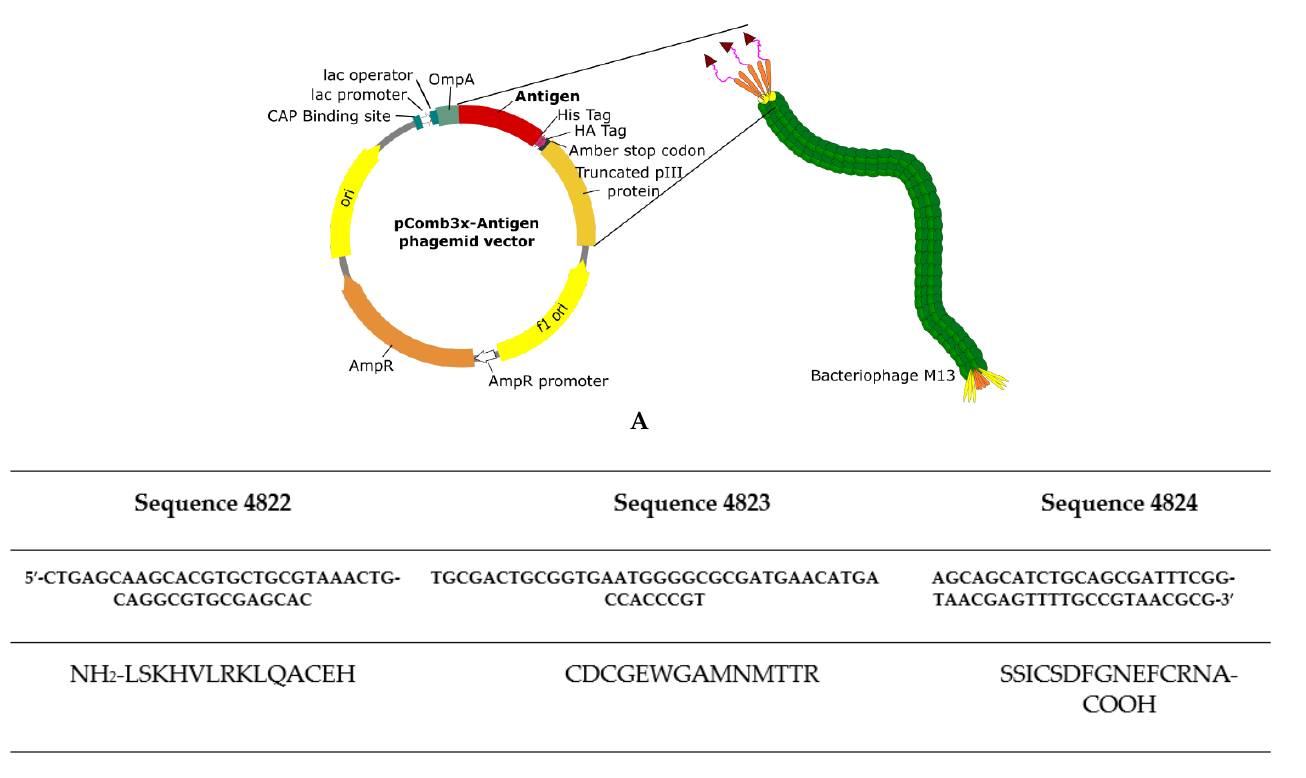
Figure 1. Schematic representation of the phage-based vaccine design. ( A ). A pComb3x phagemid vector was used to fuse antigens to a truncated pIII protein of bacteriophage M13. It contains a His-tag at the carboxy-terminal to the antigen fragment for IMAC purification. A hemagglutinin (HA) tag was also inserted to facilitate detection using an anti-HA antibody. The amber stop codon allows the expression of soluble antigens in non-suppressor strains of bacteria without eliminating the truncated pIII gene fragment [27]. ( B ). Sequence of the Sbm7462 antigen. Peptides derived from the Bm86 protein are depicted [28]. The peptides are continuously aligned in one expression construct.